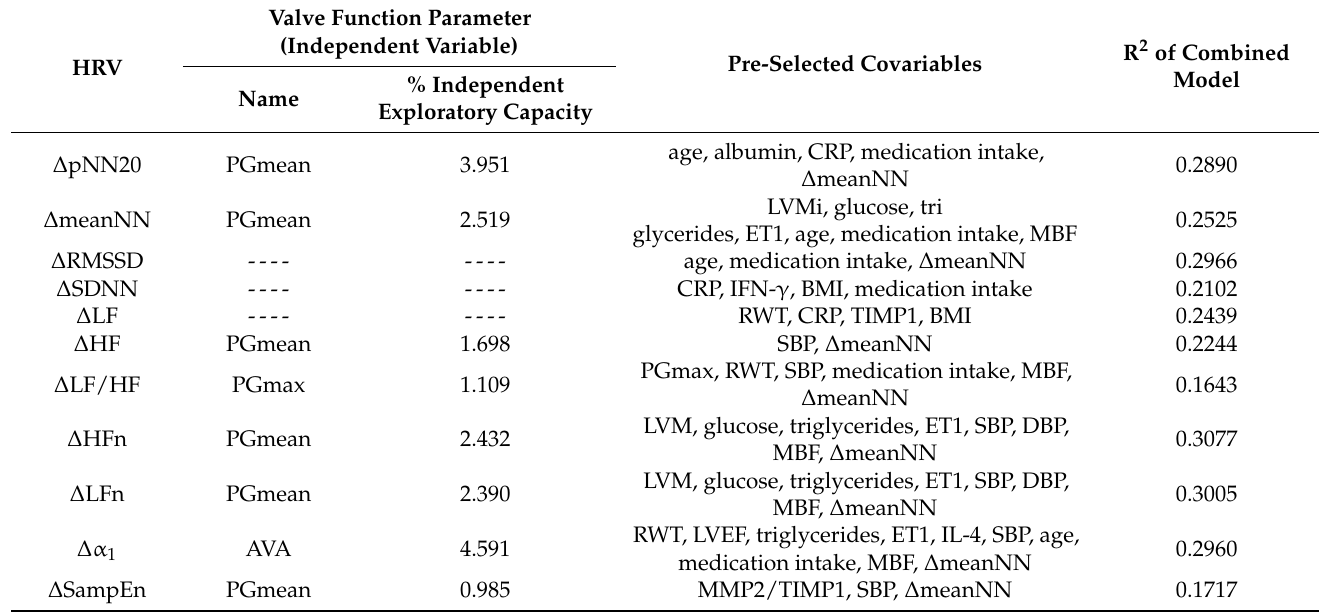
Table 5. Results of the hierarchical partitioning analysis for each independent variable (indicated as HRV in the first column). The name of the independent variables and its independent contribution to the R 2 of the hierarchical partitioning combined final analysis are shown in columns 2 and 3. The models where there were no valve parameter function-independent variables included are indicated as dashed lines (----). The column 4 shows the pre-selected covariables included in the hierarchical partitioning analysis, as previously selected by applying multiple linear stepwise regression models for each dependent variable (see Section 2.8). The last column provides the R 2 of the combined model assessed by the hierarchical partitioning